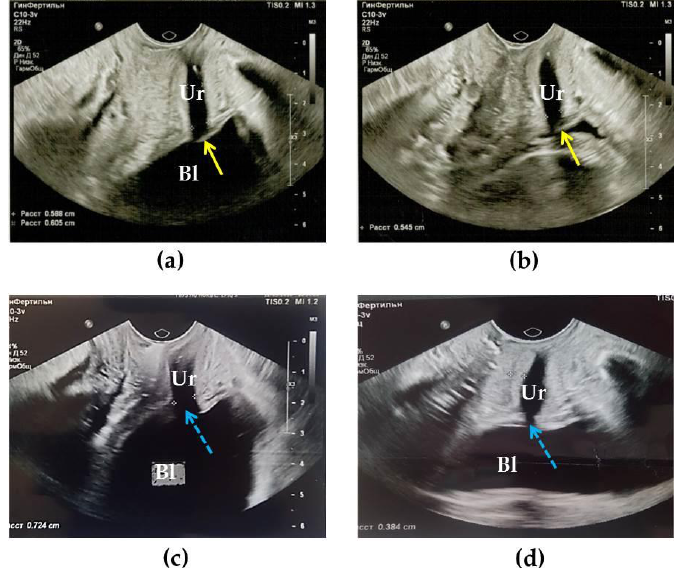
Figure 2. Transvaginal ultrasound (TVUS) of the urethra and adjacent tissues in normal conditions and with UPS. ( a , b ) A healthy woman 30 years of age before ( a ) and after ( b ) urination. The urethral tongue closes the opening to the urethra, as indicated by the yellow arrow; ( c ) Patient K., 30 years old, with a UPS disease duration of more than 10 years; ( d ) Patient Z., 38 years old, over 13 years of illness. In both cases, with UPS, the urethral tongue is indistinguishable and the gaping opening at the transition of the bladder into the urethra is indicated by the blue dashed arrows. Bl—bladder, Ur—urethra.